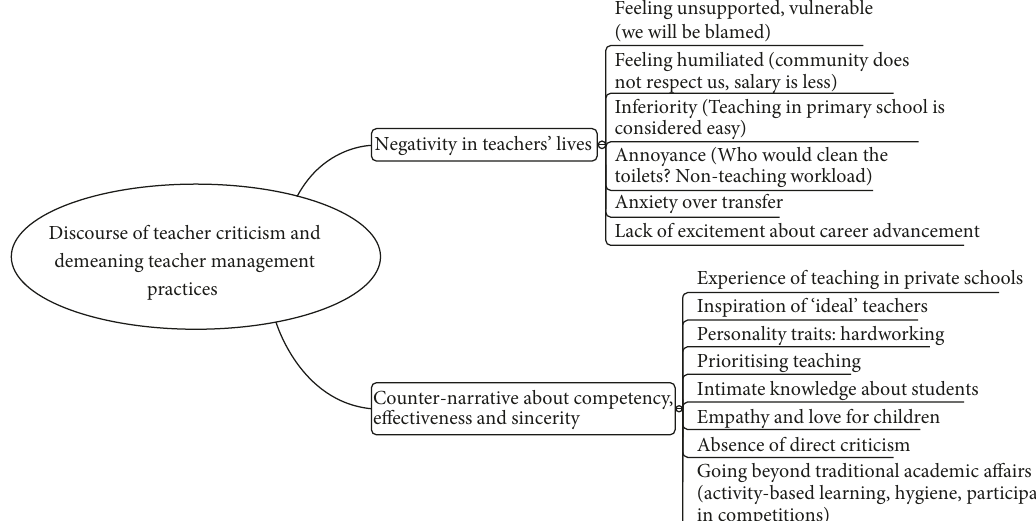
Figure 2: Effects of the discourse of teacher criticism on